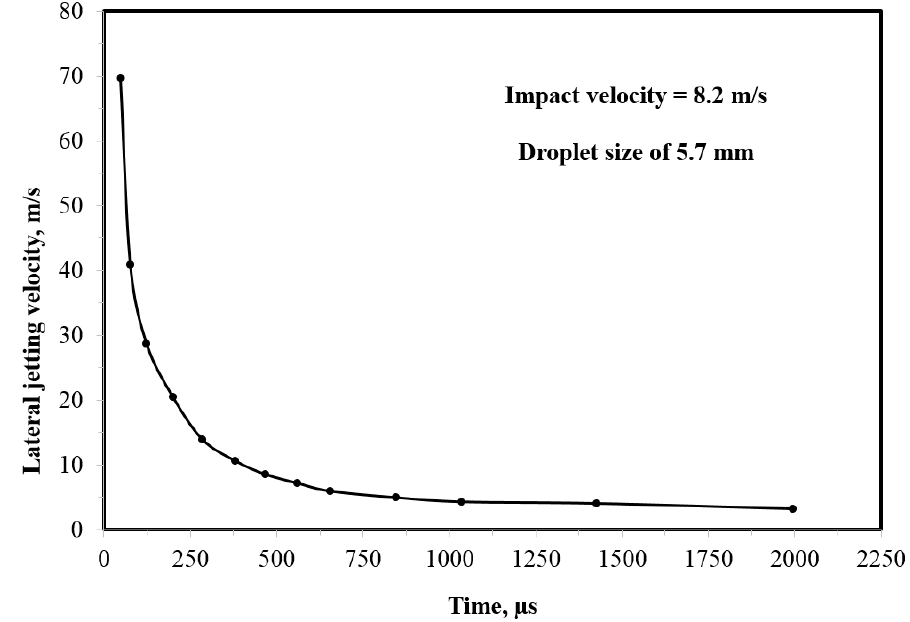
Figure 10. Time dependency of lateral jetting velocity at specific impact event. Redrawn from experimental data of [77].